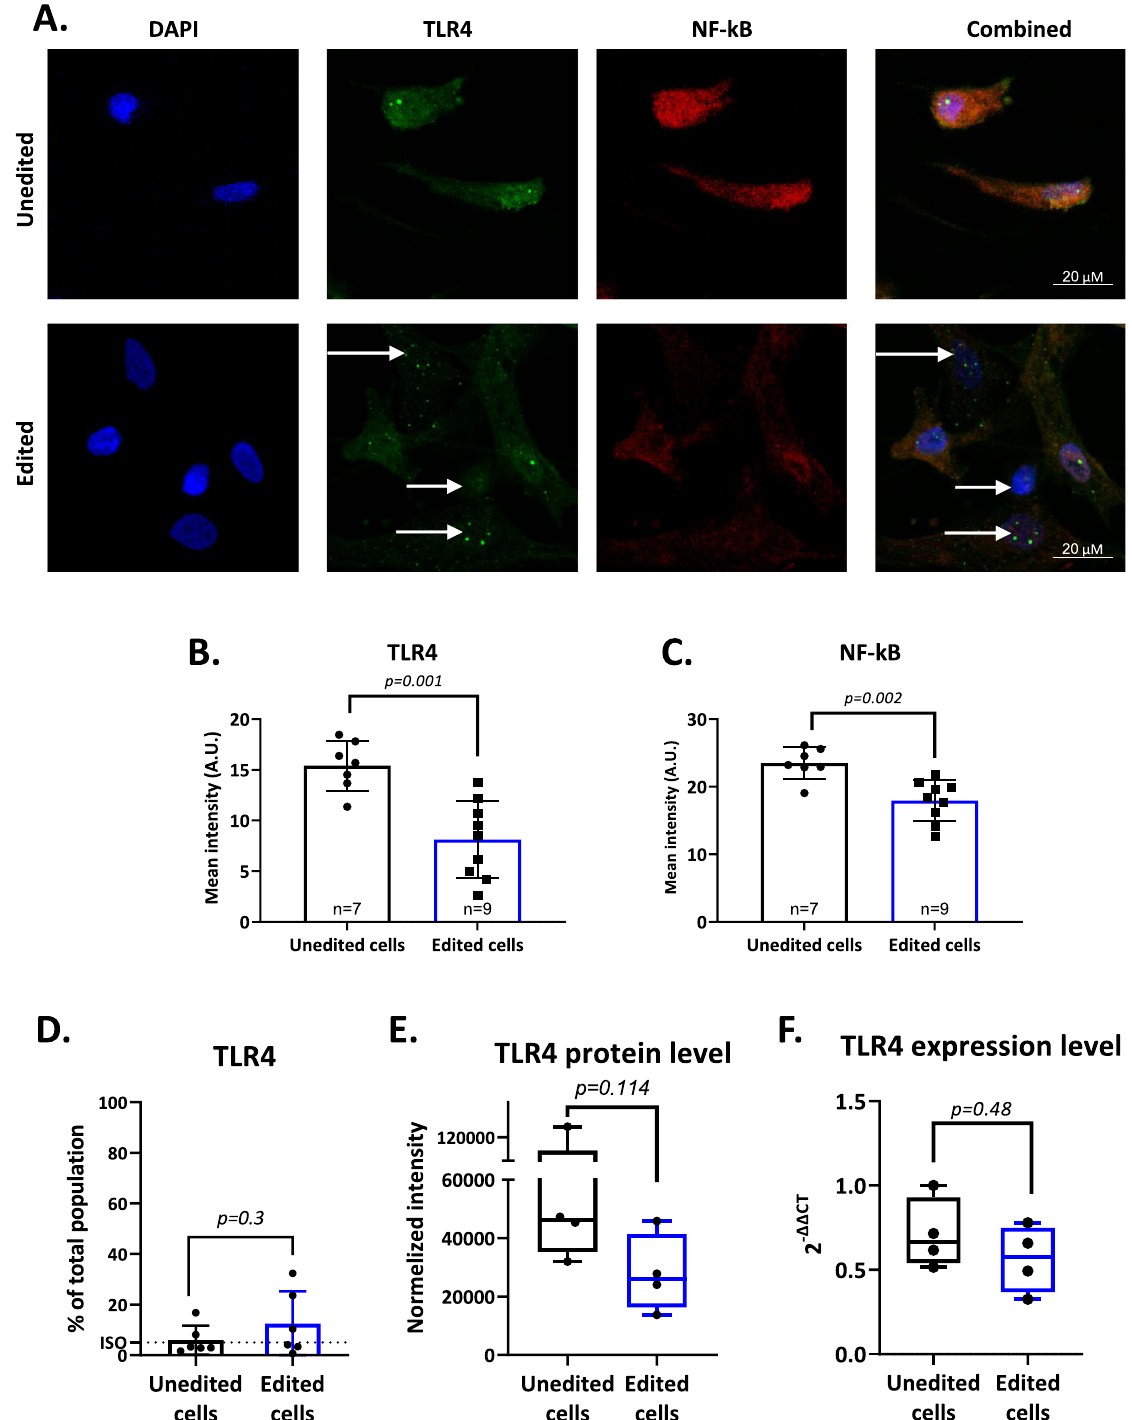
Figure 2. Effect of TLR4 Gene Disruption on Human MSCs. ( A ) Representative immunofluorescent images of hMSCs with anti-TLR4 and anti-NF- ƙ B antibodies. White arrows indicate edited cells with little expression of TLR4 and no visible NF- ƙ B after editing. ( B , C ) Quantification of TLR4 and NF- ƙ B staining in hMSCs following TLR4 gene editing using ImageJ 1.53c, http:// imagej. nih. gov/ ij 72 . Each sample represents one field of view acquired from three replicates in two separate experiments. Analysis of images shows a reduction of TLR4 expression after editing and less NF- ƙ B expression. P-values by Mann–Whitney test. ( D ) TLR4 expression was measured by FACS and showed no significant signal over isotype read in both groups. Considering that no membrane permeabilization was done, we posit this was likely due to the internalization of the TLR4. ( E ) Using western blot quantification, we found a 50% decrease in TLR4 protein levels. Cropped images as well as full raw images of data can be found in Supplementary Figure 2A. ( F ) Gene expression analysis by qRT-PCR revealed no significant differences in the levels of mRNA with and without editing. Statistical analyses for all TLR4 comparisons by Mann–Whitney test, n = 4. Abbreviations hMSCs, human mesenchymal stromal cells; TLR4, toll-like receptor 4; NF- ƙ B, nuclear factor-kappa B; FACS, flow cytometry; mRNA, messenger ribonucleic acid; qRT-PCR, quantitative reverse transcription-polymerase chain